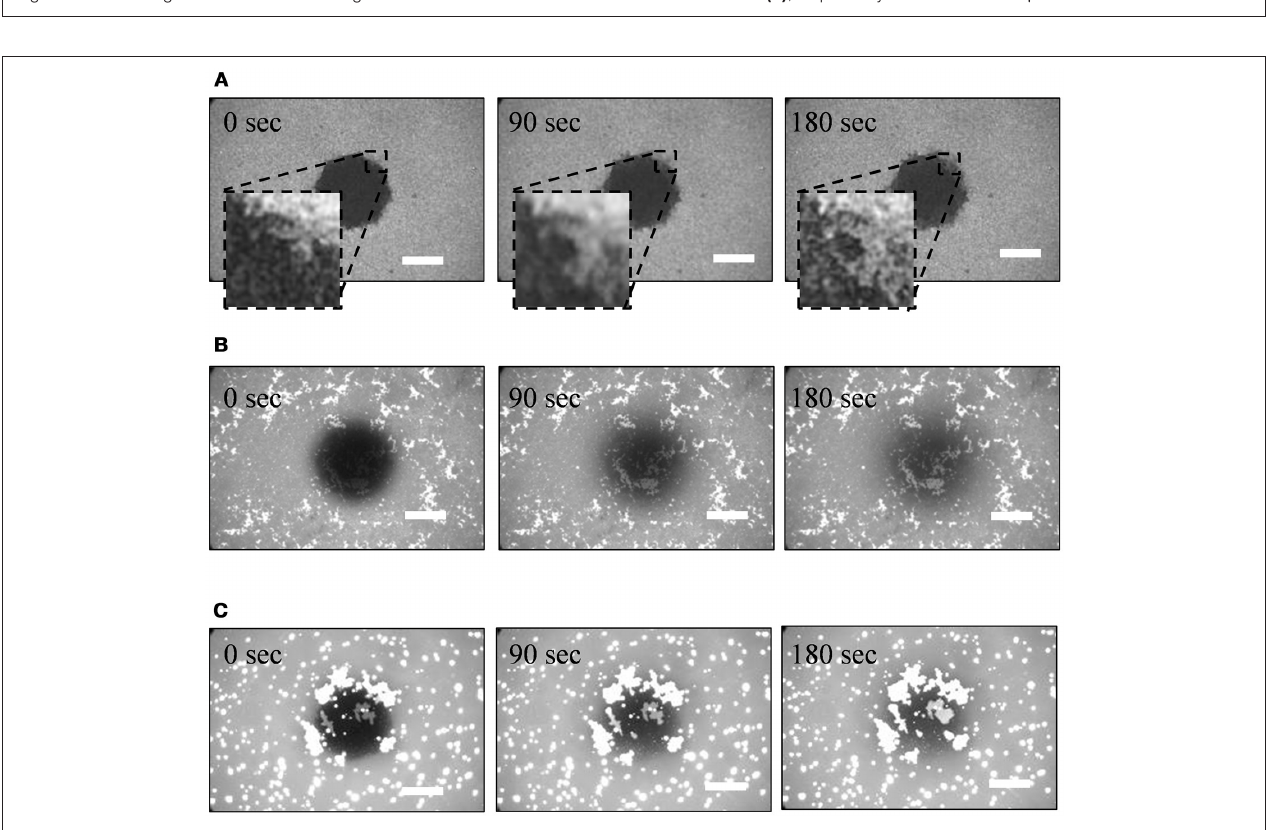
FIGURE 2 | Fluorescence recovery after photobleaching (FRAP) processes of PLE-SLBs with [Ca 2 + ] = (A) 2.0mM, (B) 3.0mM, and (C) 5.0mM. Scale bars are 50 µ m.